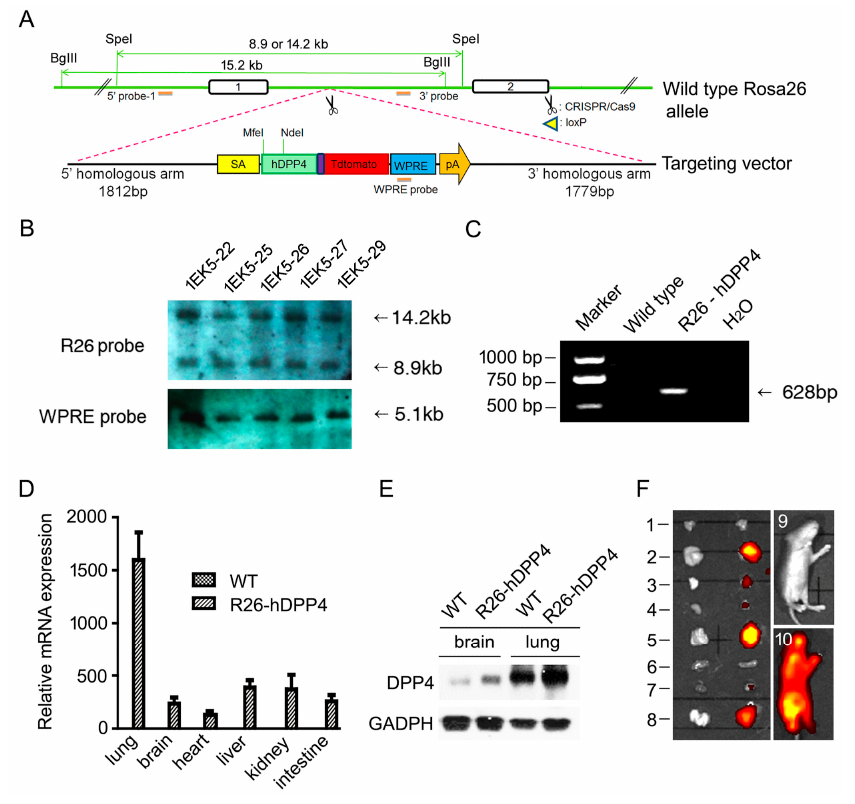
Figure 1. Establishment of a R26-hDPP4-knockin mouse model. ( A ) Schematic strategy for generation of R26-hDPP4-knockin mice via CRISPR/Cas9. ( B ) For the R26 probe, genomic DNA was digested with Spe I, and the expected sizes of wild-type and gene-targeted bands were 8.9 kb and 14.2 kb, respectively. For the WPRE probe, genomic DNA was digested with Bgl II, and the expected size of the gene-targeted band was 5.1 kb. Four representative results are shown. ( C ) PCR genotyping of R26-hDPP4 mice. The primer pair was designed to anneal in the coding region of hDPP4, and the expected PCR amplicon was 628 bp in length. ( D ) Quantitative reverse transcription PCR (RT-qPCR) of hDPP4 mRNA in R26-hDPP4 mice and wild-type C57BL/6 mice. Values are presented as means ± SEMs of three independent experiments and were normalized to GAPDH levels. No expression of R26-hDPP4 in wild-type mice was detected. ( E ) Detection of DPP4 protein by western blotting in brain and lung. Weaker blotting signal was detected in wild-type mice, indicating the anti-hDPP4 antibody could recognize mDPP4. ( F ) Bioluminescence imaging (BLI) of newborn R26-hDPP4-knockin mice showing hDPP4 expression in their organs. The imaged organs were: (1) thymus, (2) liver, (3) stomach, (4) kidney, (5) intestine, (6) spleen, (7) heart, (8) lung, (9) and (10) the whole bodies of wild-type mice and R26-hDPP4 mice, respectively.